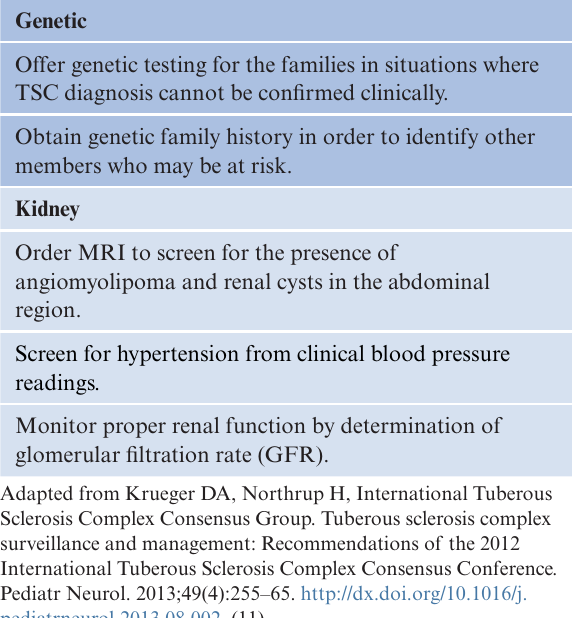
Figure 1: Normal downstream pathway of TSC1 and TSC2, and its gene products. These proteins are involved in the regulation of cell growth through the phosphatidylinosi- tol 3-kinase signaling pathway (PI3K), an inhibitor of the mammalian target of rapamycin (mTOR). TSC1: tuberous sclerosis complex 1; TSC2: tuberous sclerosis complex 2; Rheb: Ras homolog enriched in brain; GTP: Guanosine tri- phosphate; Raptor: regulatory-associated protein of mTOR; mLST8: target of rapamycin complex subunit LST8; mTOR: mammalian target of